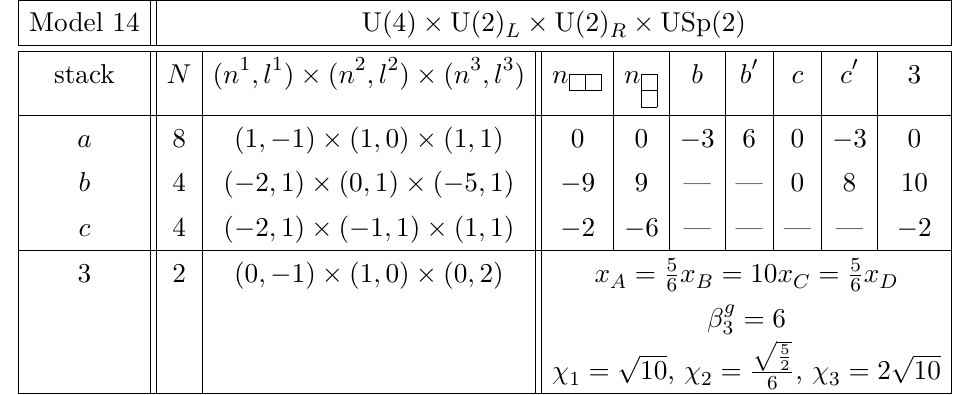
Table 21 . D6-brane configurations and intersection numbers of Model 14, and its MSSM